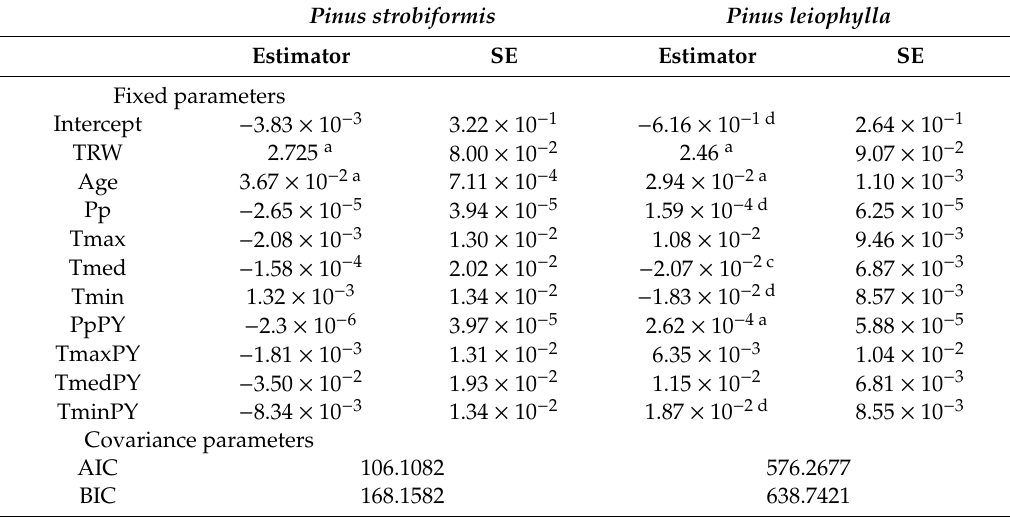
Figure 2. Average trends and standard error (mean ± SE) of the variables annual ring width (TRW) and annual carbon accumulation for the period 1962 – 2016. Table 2. Estimates of mixed linear models for carbon accumulation in the tree rings of the two species